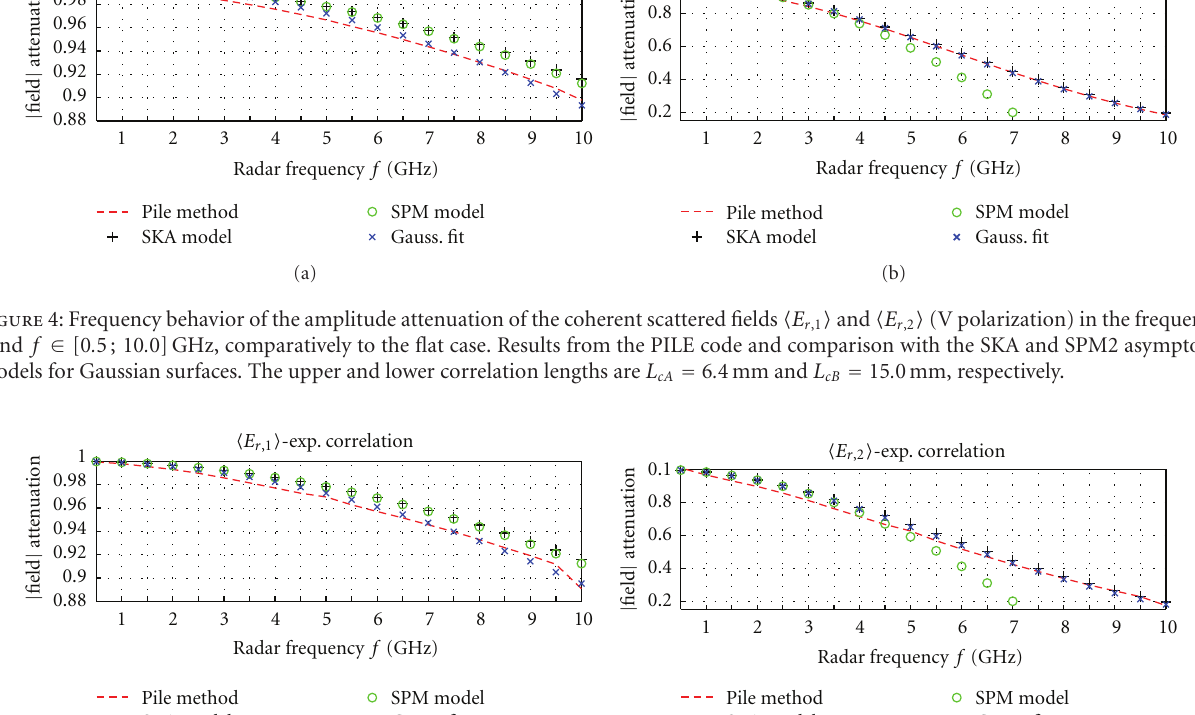
f = 4GHz, Ra r ,1 = 0 . 084, whereas Ra r ,2 = 0 . 362. By using